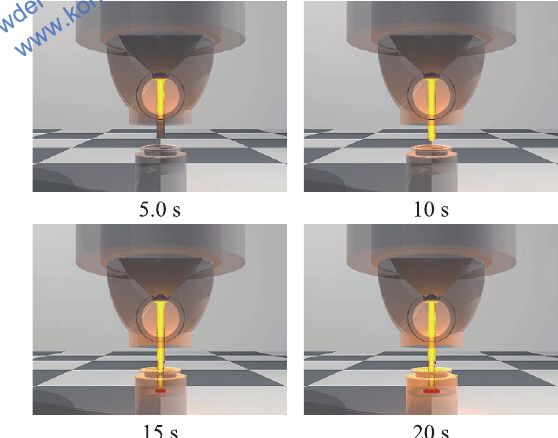
Fig. 8 Highly viscous fluid flow in a glass melter (Sun et al., 2012) Copyright: (2012) Elsevier B.V.